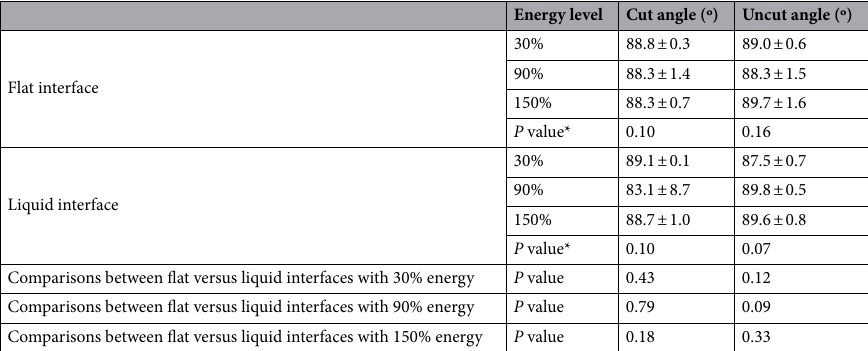
Table 1. The cut and uncut angle measured for both interfaces at different levels of energy. *Comparisons among three energy groups.